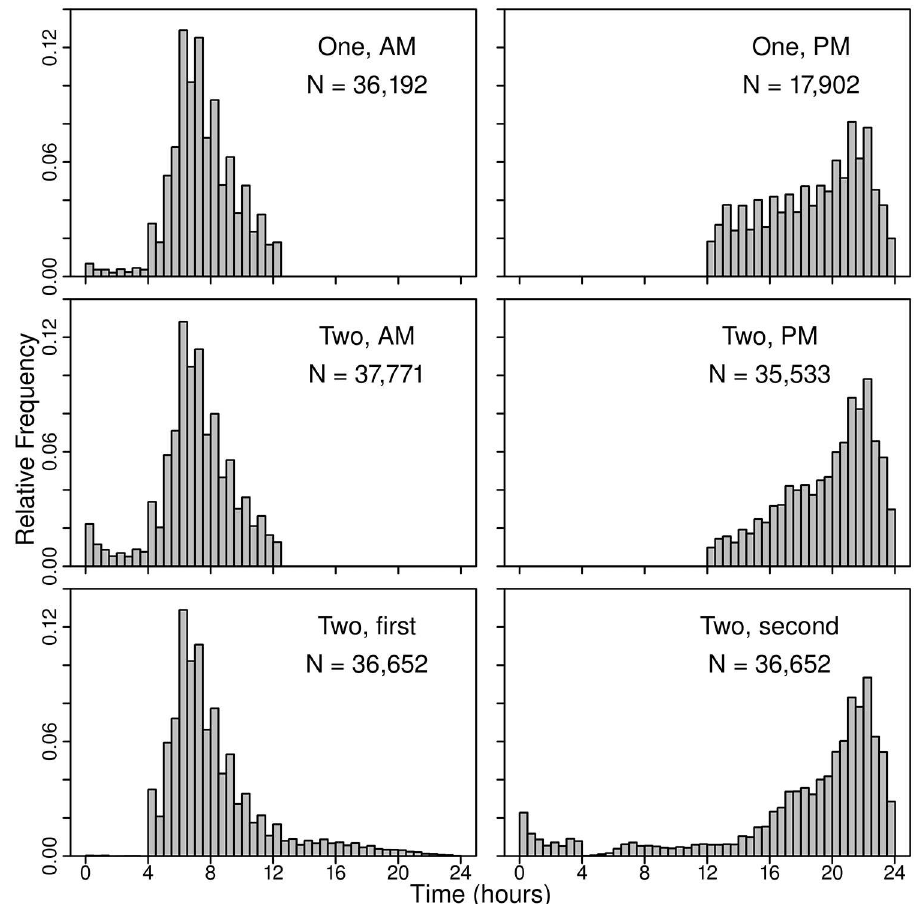
Fig 2. Weighted histograms of starting times of grooming events reported in ATUS from 2003 to 2012. Results are presentedfor cases for which one and two events were reported. Results for single events are separated into cases in which events occurred before noon and after noon (top row). For cases with two events, results are presentedseparately for events occurring before and after noon (middle row) and also for the first and second of the two events (bottom